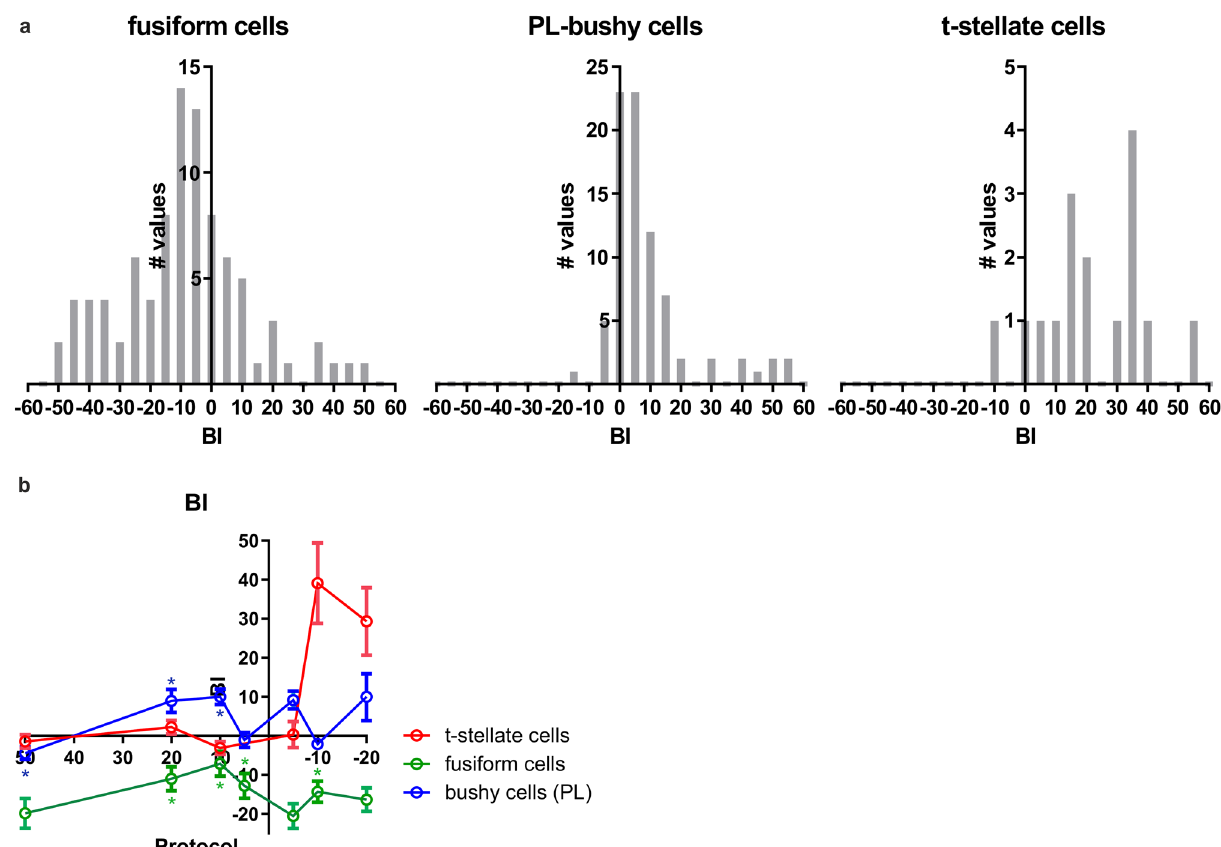
Figure 6. Bimodal integration index. ( a ) Histograms of the BI (bimodal integration index) for bimodal protocols where the spiking was increased compared to only sound stimulation. In fusiform cells, and primary- like bushy cells the BIs for the + 20 & + 10 protocols are plotted. For the t-stellate cells the − 20 and − 10 protocols. Two values for each cell, one for each of the two protocols. (For the t-stellate plot, four values with a BI > 60 are not included in the plot.) ( b ) The BI (mean ± SD) for all recorded protocols in fusiform cells, primary-like bushy cells and t-stellate cells. * in the corresponding colour mark the protocols where there was a significant difference in spiking activity between bimodal and sound